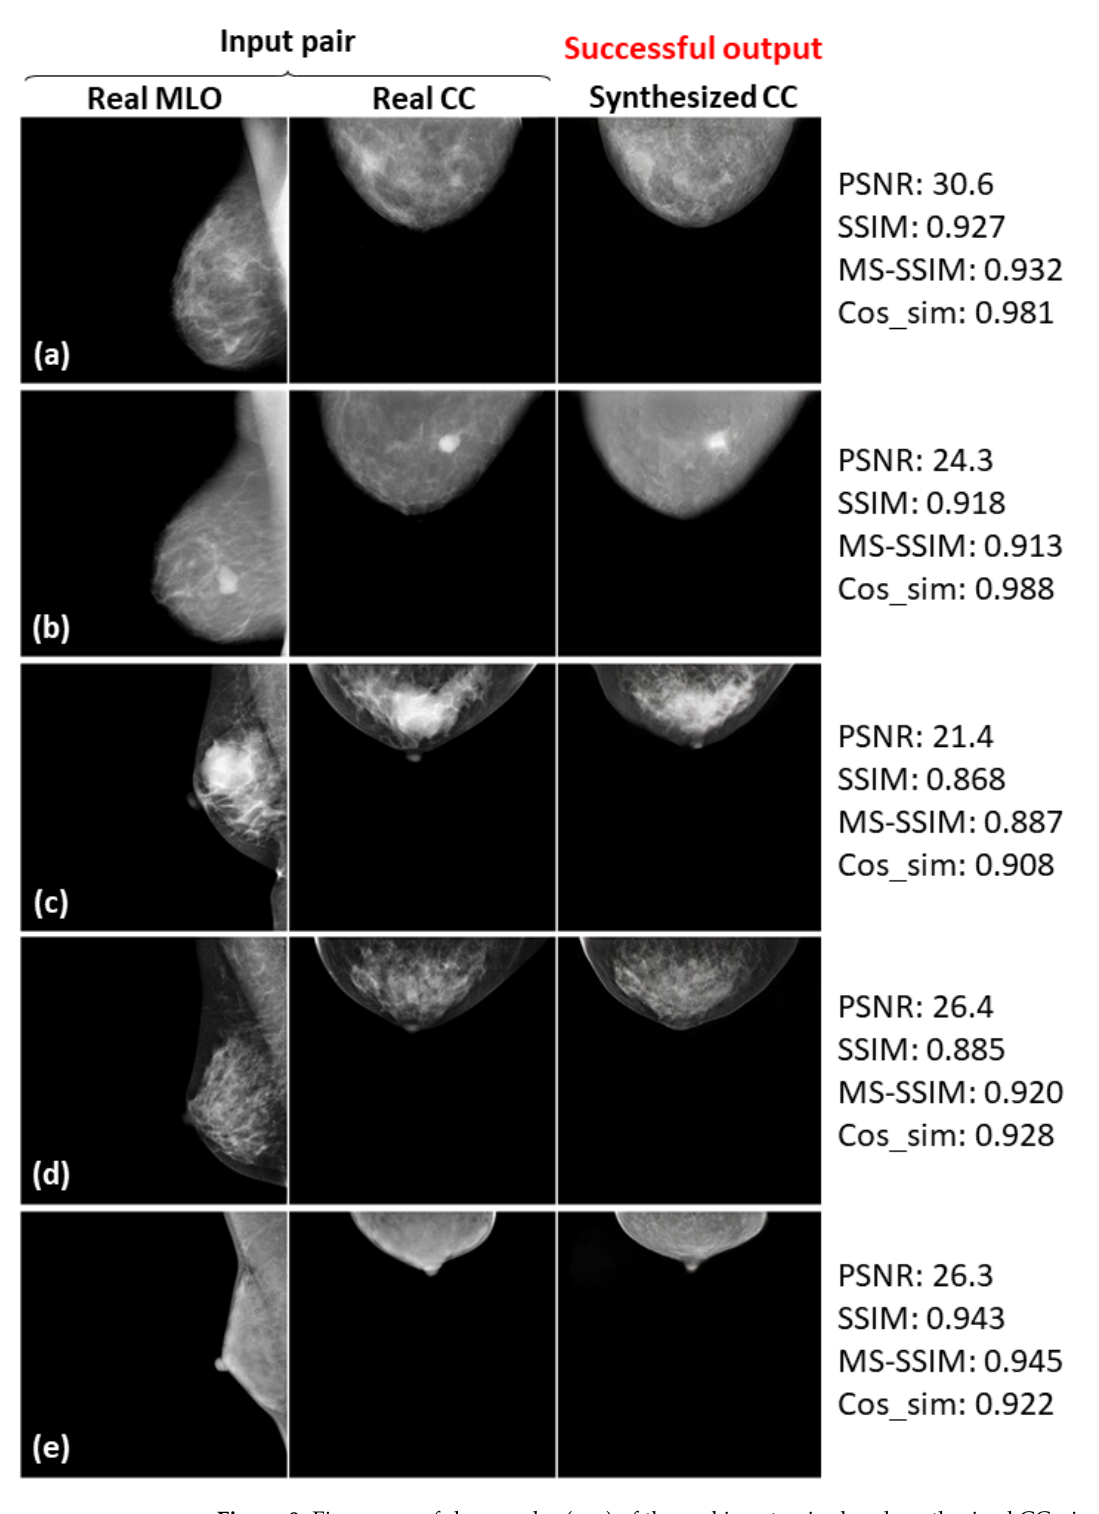
Figure 9. Five successful examples ( a – e ) of the real input paired and synthesized CC-view mammo- grams at 256 × 256 resolution by bi-directional training of CR-GAN incorporating PG technique and feature matching